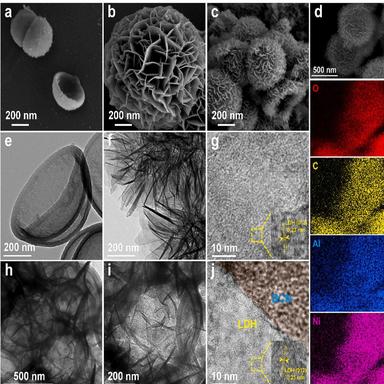
FE-SEM images of (a) BCN, (b) LDH and (c) BCN@LDH. (d) SEM-EDS mappings of elemental C, Al, O and Ni in BCN@LDH. TEM images of (e) BCN, (f) LDH and (h, i) BCN@LDH under different magnifications. High-resolution TEM image of (g) LDH and (j) BCN@LDH.